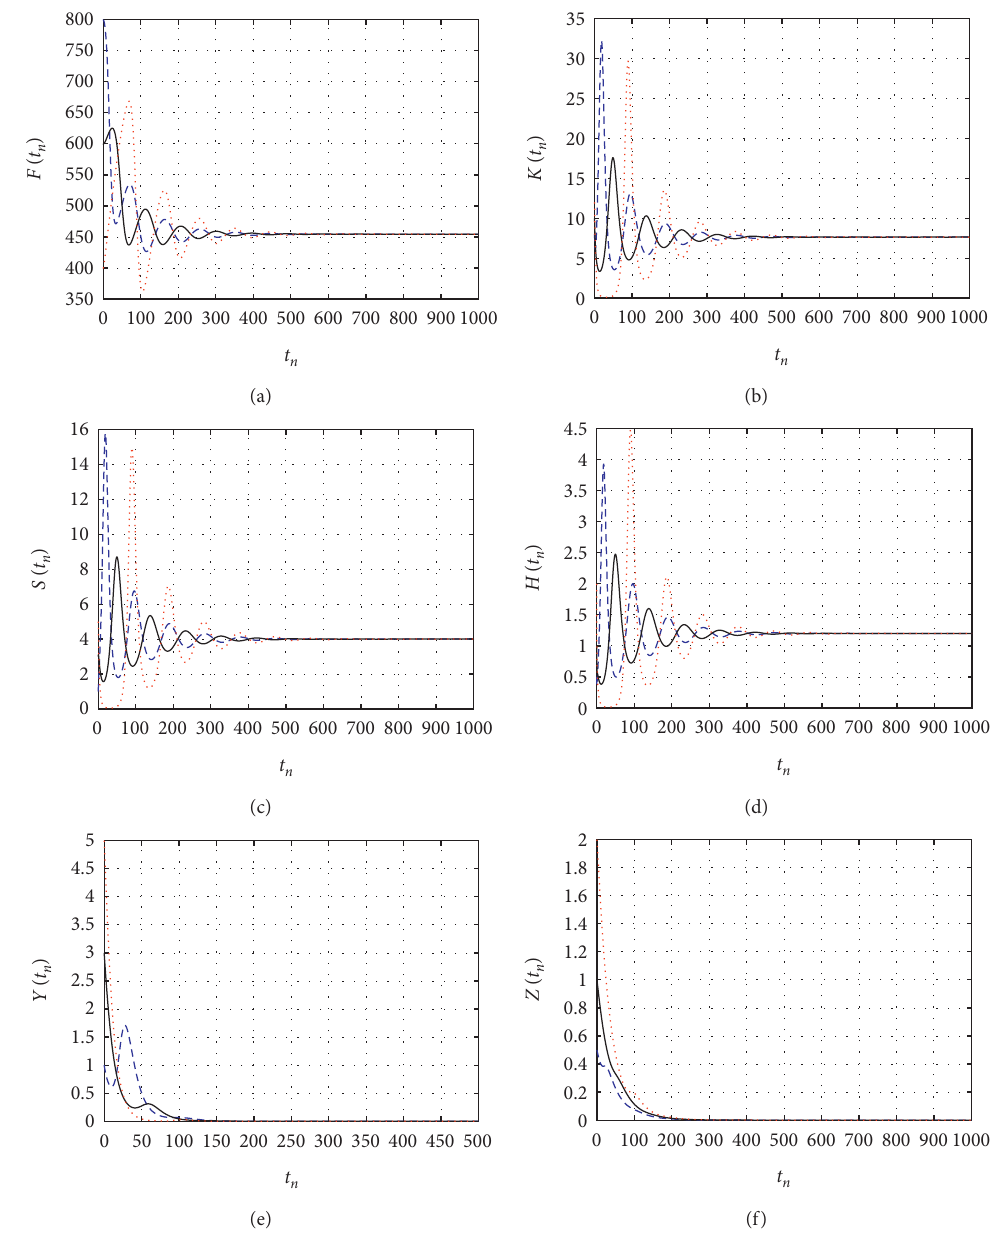
Figure 2: The solutions of systems (12)–(17) for case R Y